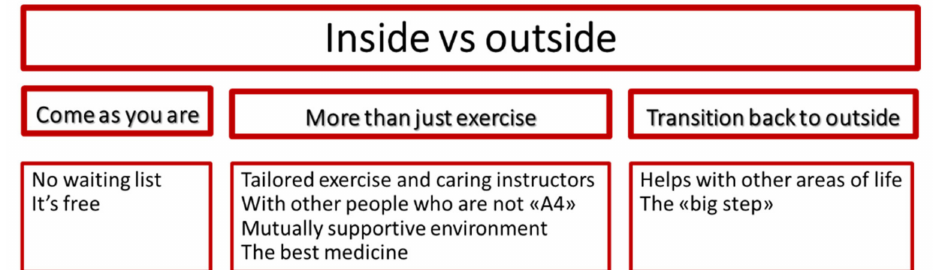
Figure 1. Overarching theme, main themes, and